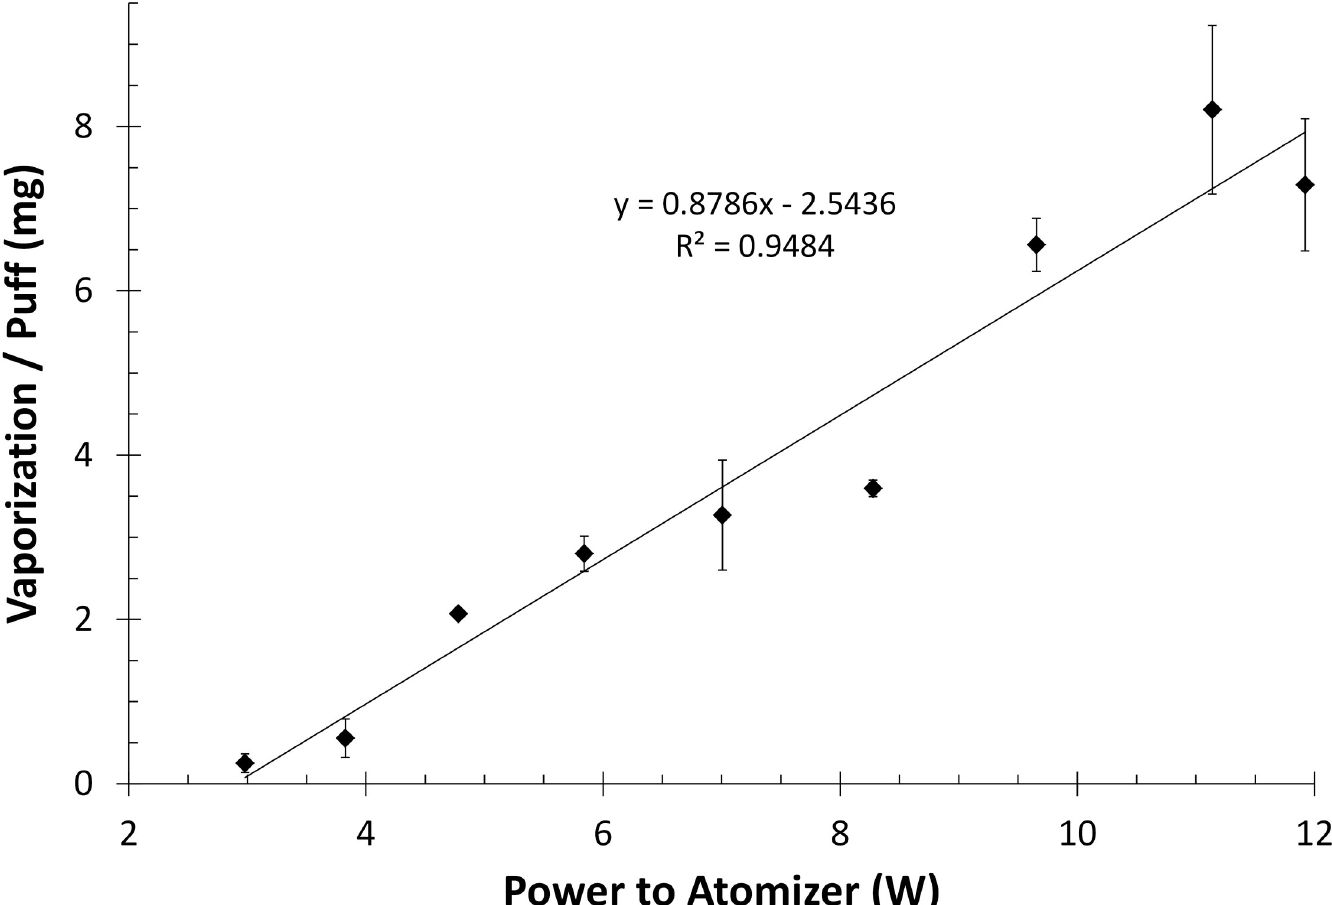
Fig 2. Vaporization rate per puff of a G2 EC atomizer with total resistance of 3.02 O . Vaporization rate per puff of a 3.02 O single coil EC atomizer was measured by weight difference across a 10 puff series with 30 seconds between puffs at 9 wattages. EC atomizer was powered by a laboratory power supply for these experiments. Each point is the average vaporization per puff with standard error